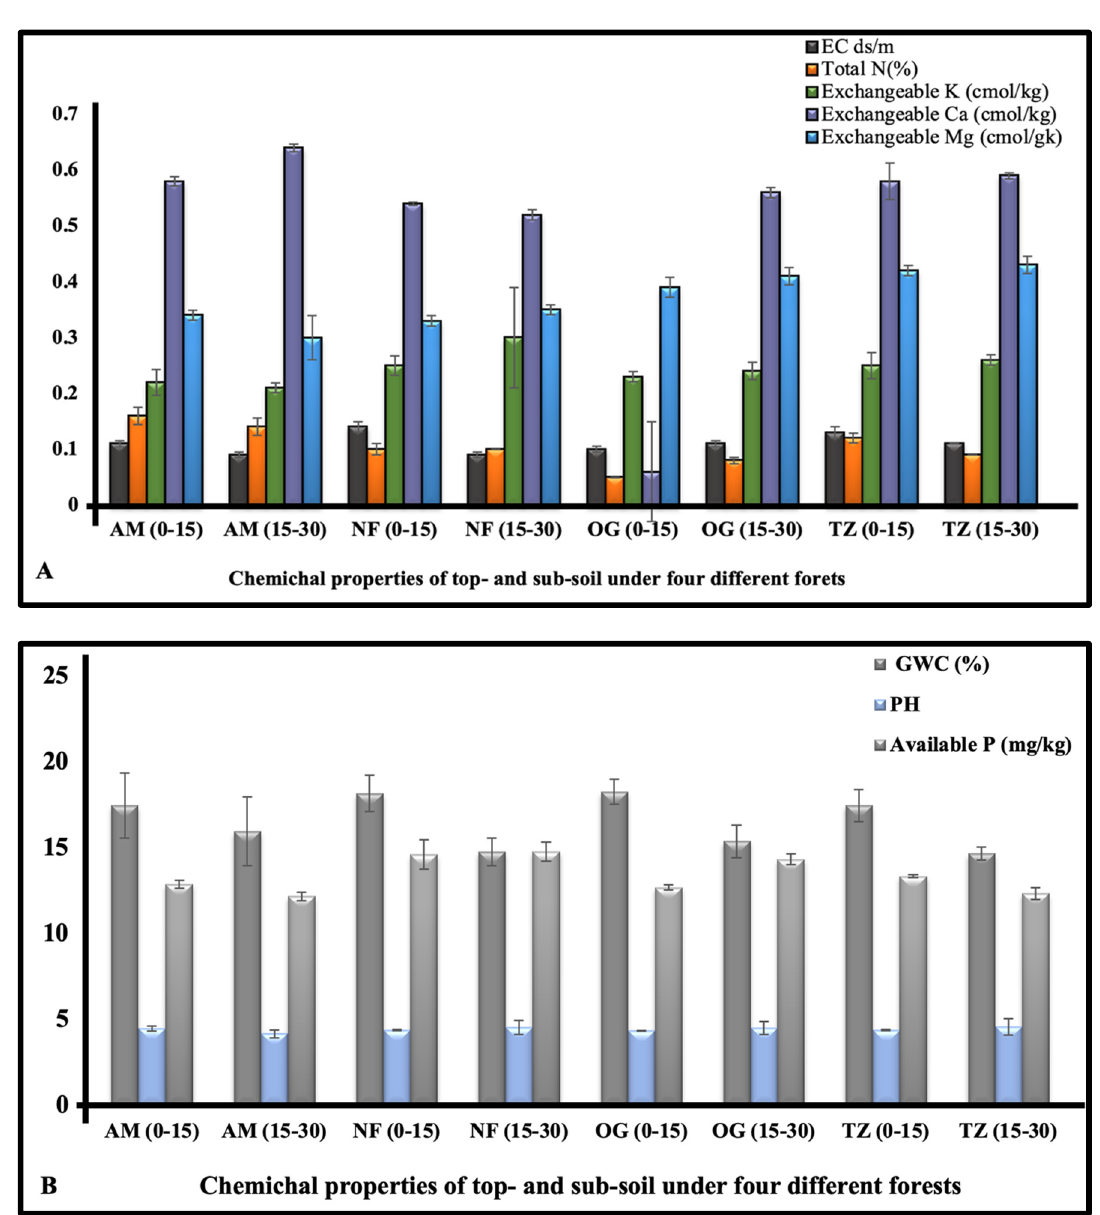
Figure 7. Measurements of ( A ) electrical conductivity (EC), total nitrogen (N), exchangeable calcium, exchangeable magnesium, and exchangeable potassium, and ( B ) gravitational water content, available phosphorus, pH, and organic matter of top and subsoil (15–30 cm depth) in Ayer Hitam FR across four different regions. Note: AM = Acacia mangium region, TZ = Transition region, OG = Open ground region, NF = Native Forest region. Distinct letters imply significant distinctions between arsenic concentrations following Duncan’s multiple comparison test ( p ≤ 0.01).